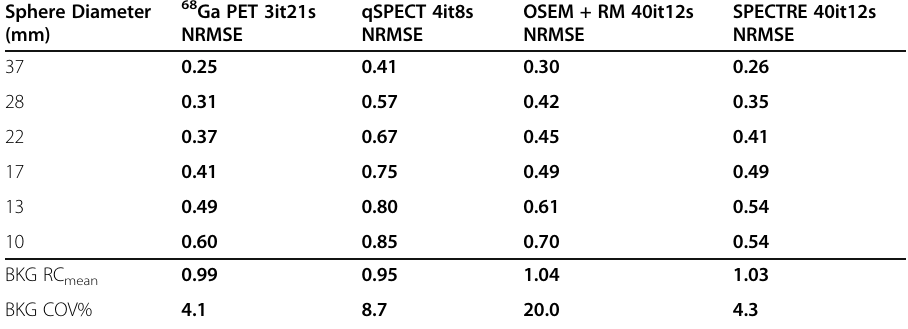
Table 1 NRMSE in the sphere VOIs and COV% and RC mean in the background ROIs for 68 Ga PET, qSPECT, OSEM + RM and SPECTRE. BKG is the background compartment of the phantom 68 Ga PET 3it21s Sphere Diameter qSPECT 4it8s OSEM + RM 40it12s (mm) NRMSE NRMSE NRMSE